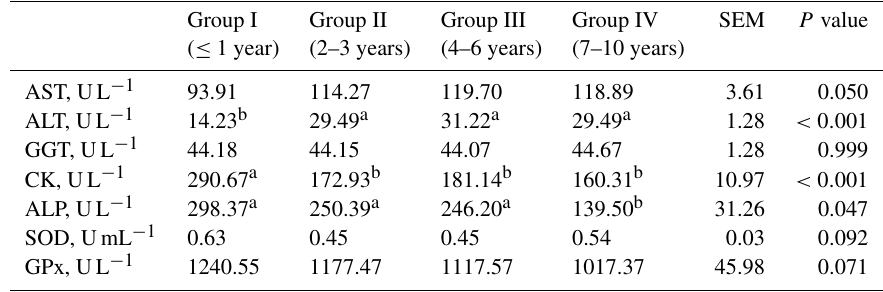
Table 4. Blood enzymes activities from goats of different ages.